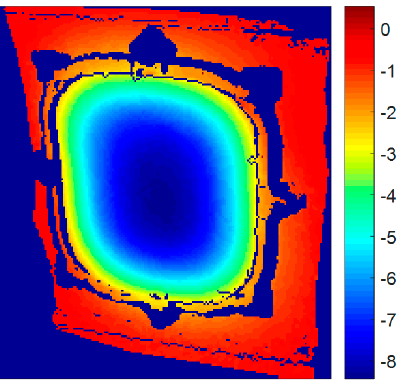
Figure 15. Static out-of-plane deformation (mm) of the window frame under differential pressure.